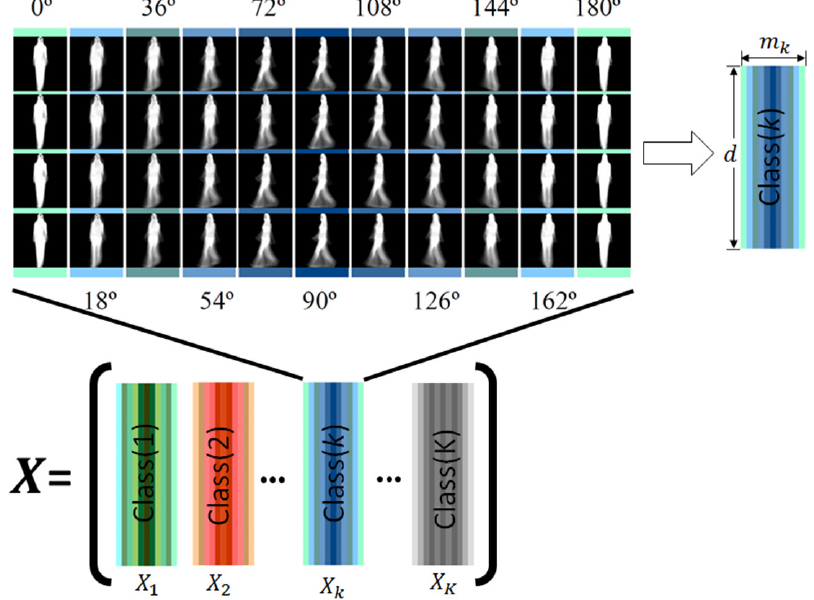
Figure 3. Illustration of the joint model constructed by using the training data corresponding to K-classes using gait energy images (GEIs) of the CASIA-B database [15]. The class (k) in this figure consists of all different view angles V and samples available for subject